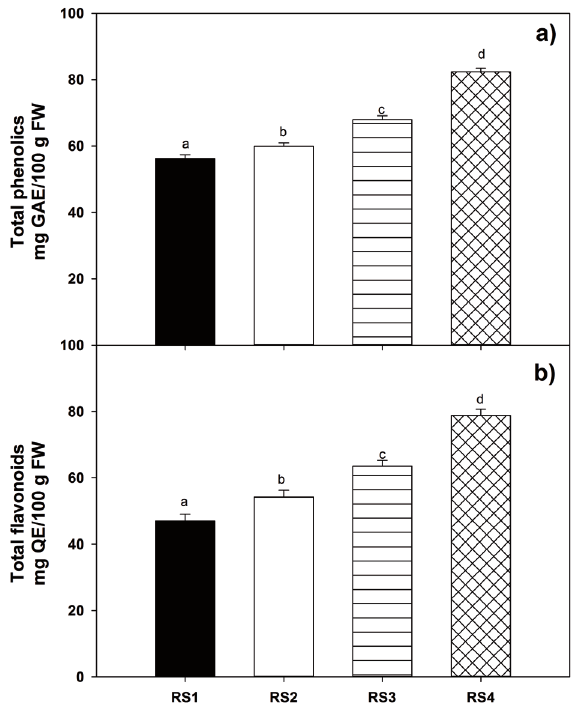
Fig. 2: Changes in total phenolic (a) and flavonoid (b) concentration in pine- apple cv. Esmeralda at four ripening stages (RS). Different letters indicate significant differences (p < 0.05), n =12.